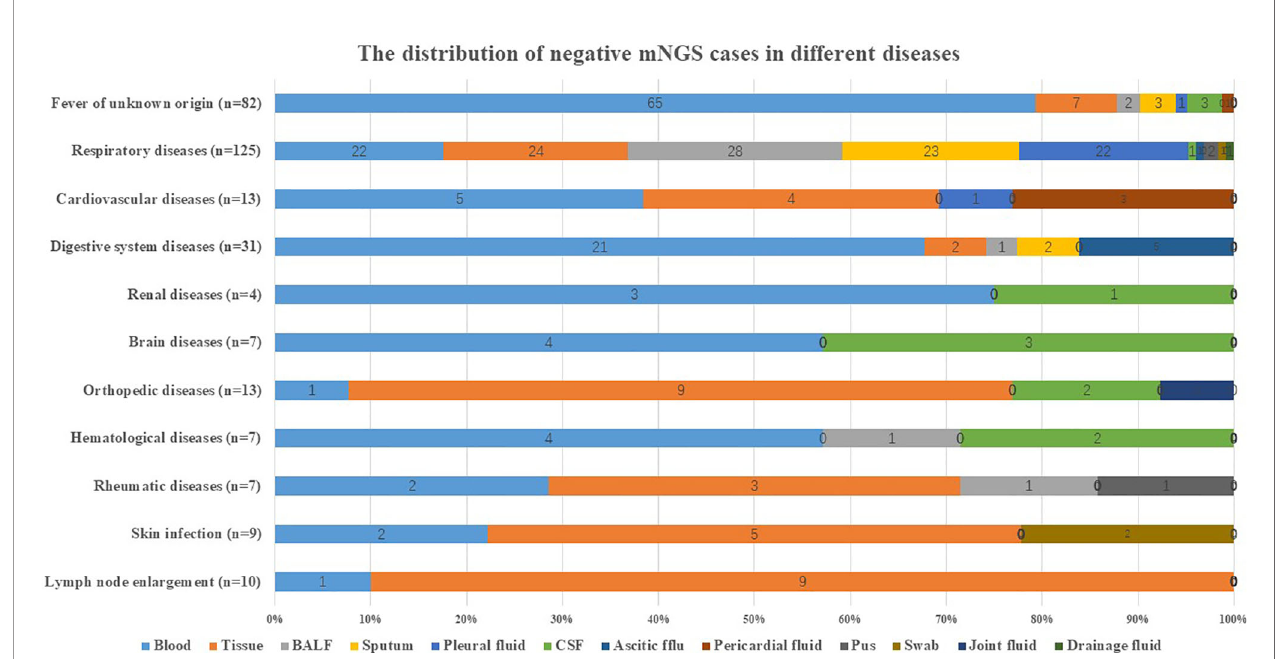
FIGURE 2 | Distribution of negative mNGS cases in diseases. The distribution of negative mNGS cases in different diseases including fever of unknown origin, respiratory diseases, cardiovascular diseases, digestive system diseases, renal diseases, brain diseases, orthopedic diseases, hematological diseases, rheumatic diseases, skin infection, and lymph node enlargement. BALF, bronchoalveolar lavage fl uid; CSF, cerebrospinal fl uid; mNGS, metagenomics next-generation sequencing.